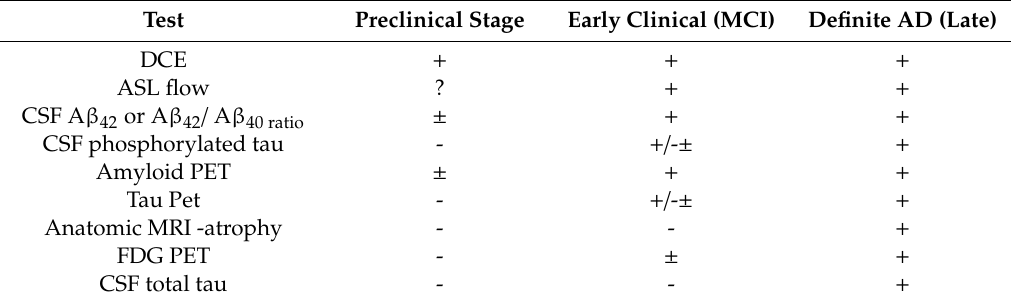
Table 2. Pathologic test sensitivity at respective stage of AD.